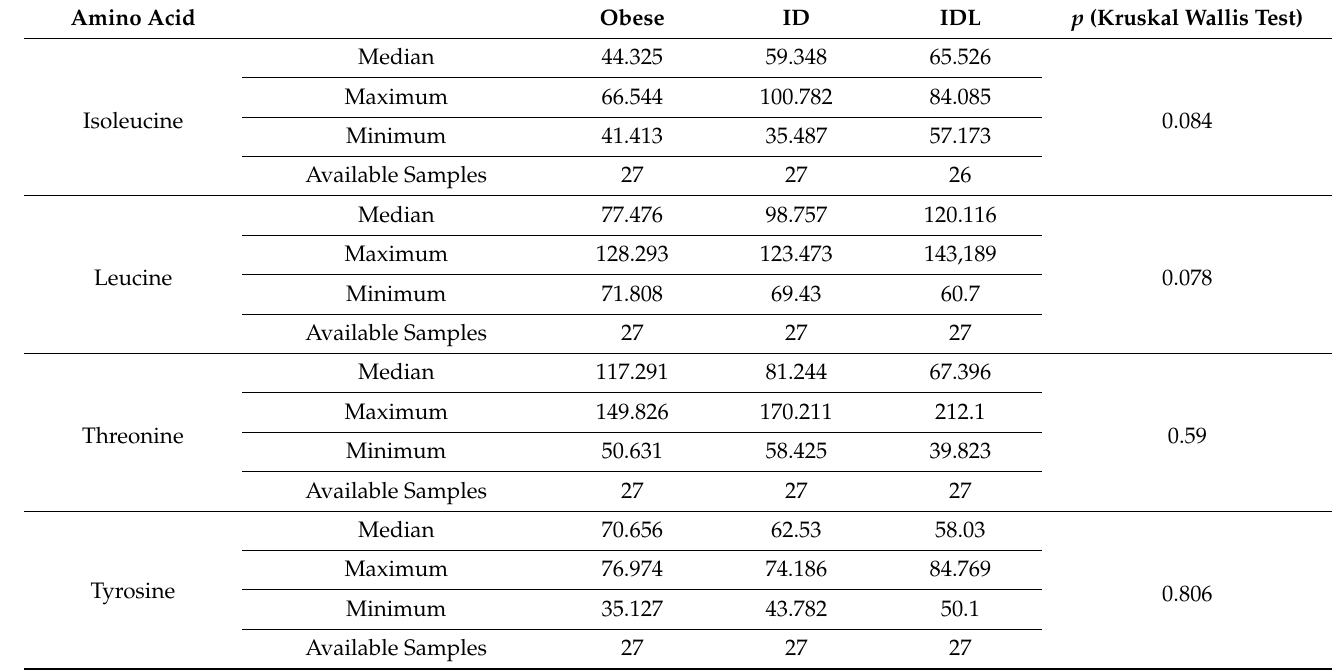
Table 4. Median, minimum, and maximum of the non-normally distributed amino acid concentrations